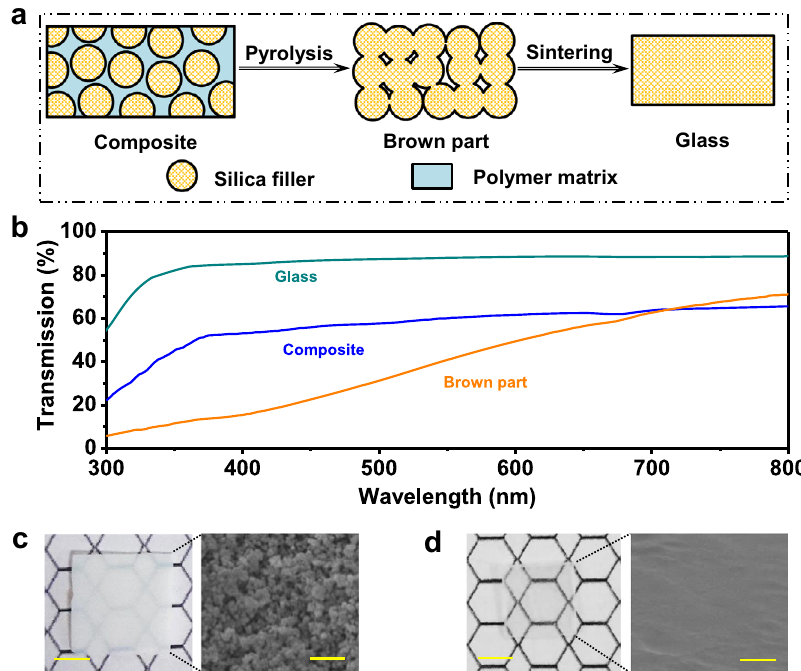
Fig. 3 Fabrications of the glass. a Schematic illustration of the pyrolysis and sintering steps for the composite. The green area is the polymer scaffold and the yellow area is the silica. b The UV-vis transmission spectrum of the composite green body, the brown part, and the glass. c The macroscopic photos and microscopic SEM images of the brown part. d The macroscopic photos and microscopic SEM images of the transparent glass. The scale bars of the photos are 1 cm and SEM images are 300 nm.